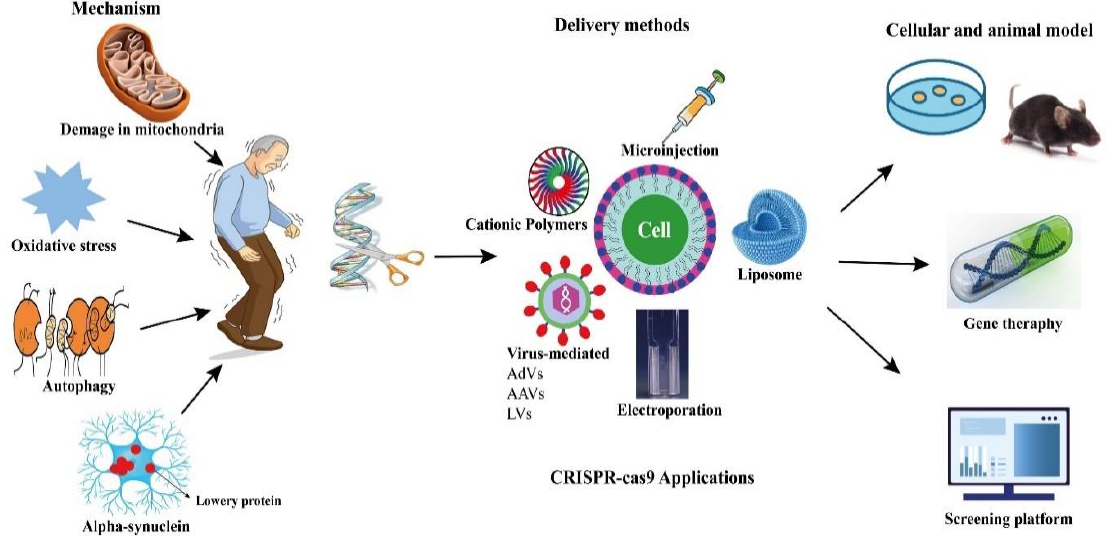
Figure 1. Potential applications of CRISPR-Cas9 in PD.